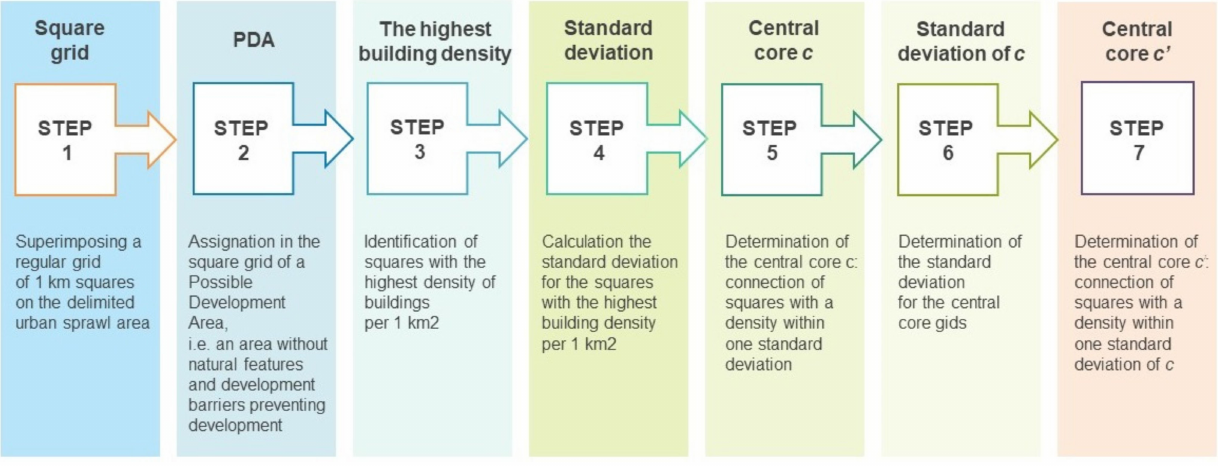
Figure 2. A simplified model of an adopted procedure for conducting nuclear analysis. Source: